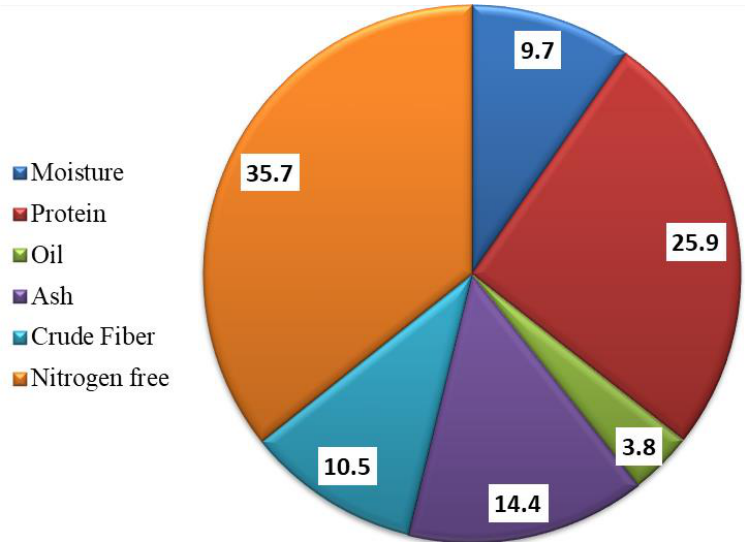
Figure 1. Composition of Moringa oleifera leaves.